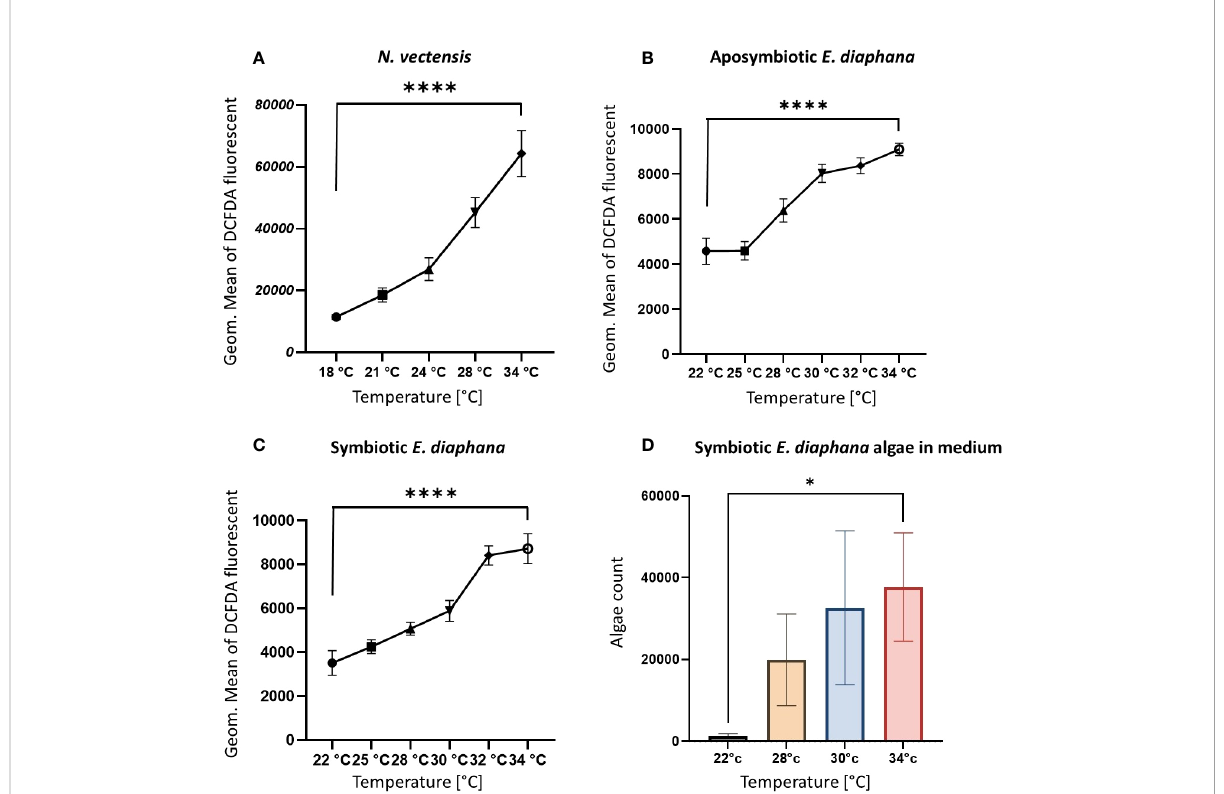
FIGURE 5 Parameters of increased heat response validation. (A, B) The levels of ROS increases on the cellular level in elevated temperatures in the N. vectensis model (A) aposymbiotic (B) and symbiotic (C) E. diaphana , measured by fl ow cytometry fl uorescence of the DCFDA marker for ROS, in each cell. Measured by Geometric mean of the green fl uorescence of the cells. (D) Counts of expelled algae from E. diaphana due to heat stress in 2.5 ml of media. Control temperature for the N. vectensis model is 18°C and 22°C is the control temperature for the E. diaphana models. Unpaired t-test analysis was performed on the ROS enrichment and algae count between the ambient temperature and 34°C. P-value legend: *: p <0.05, ****: p < 0.0005 (Supplementary Table 1). Scale bar represents